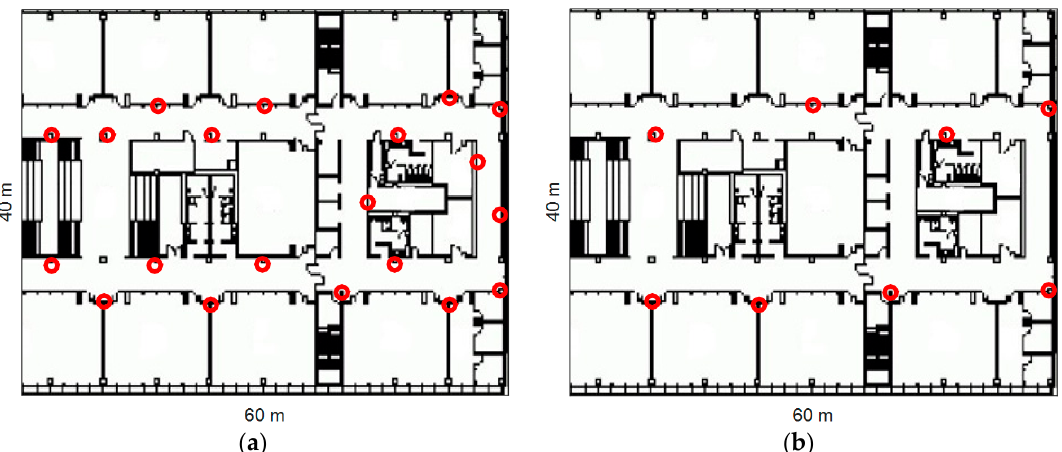
Figure 4. Experimental area (red circles = BLE beacons): ( a ) dense deployment (1 beacon per 9 m); ( b ) sparse deployment (1 beacon per 18 m).